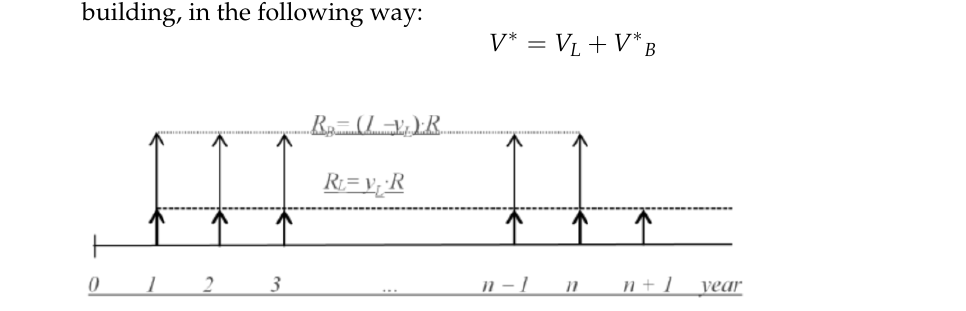
Figure 1. Transitory cash-flows.